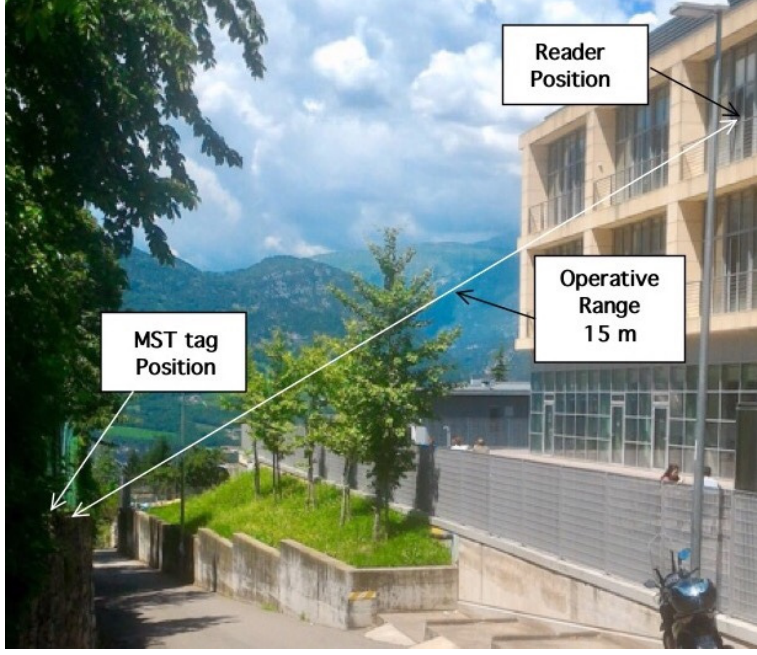
Figure 7. Photo of the experimental